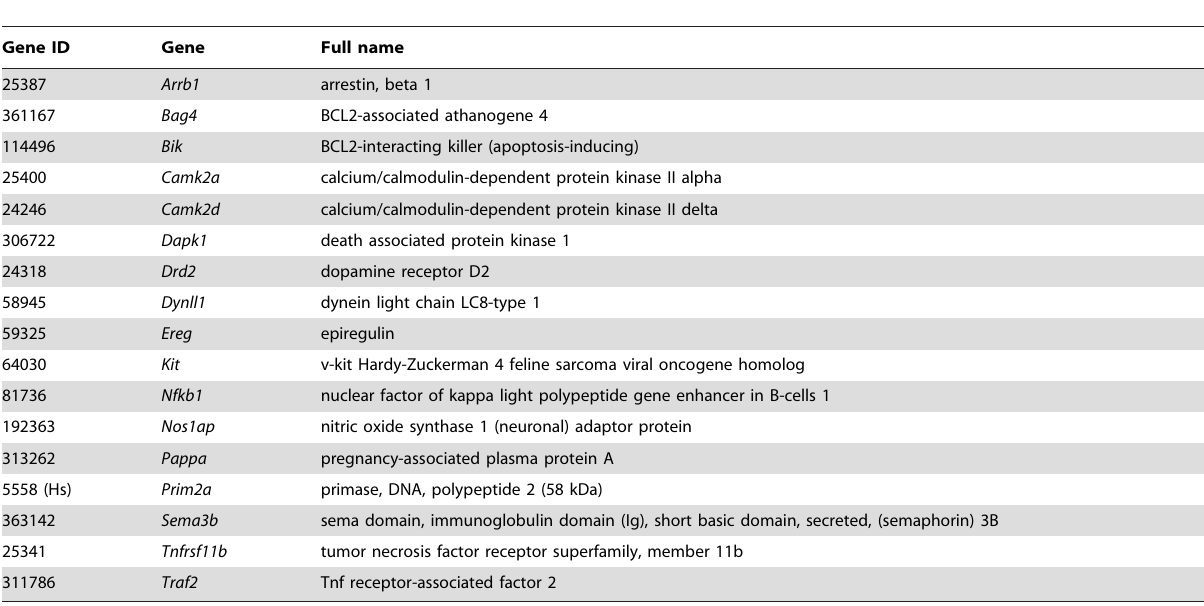
Table 2. List of PCR array genes changed by BPA treatment in prefrontal cortex of